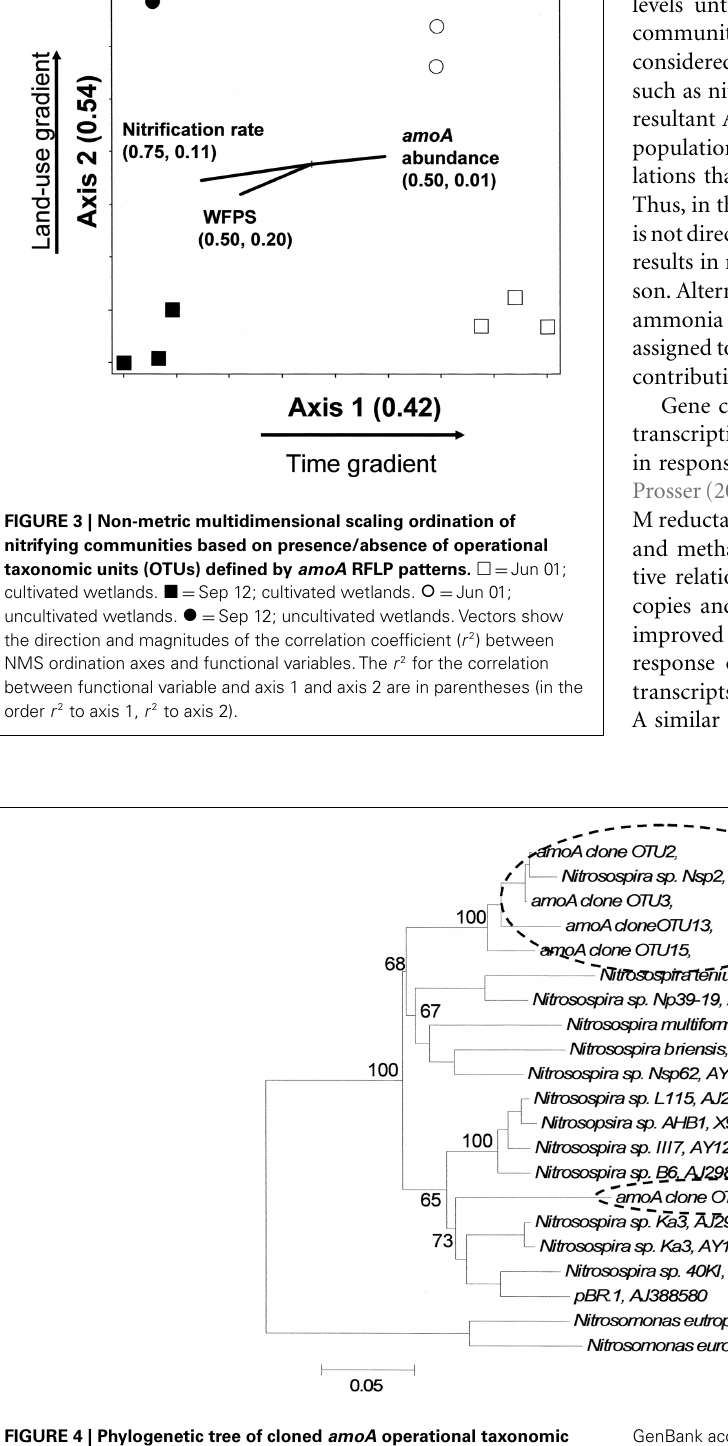
GenBank accession. Branch nodes with bootstrap values greater than 60 are labeled. Cluster labels based on Horz et al. (2004). OTU17 could not exclusively be included with Cluster 1 or 4, but it has common lineage with both clusters. Scale bar indicates 5 changes per 100 nucleotide